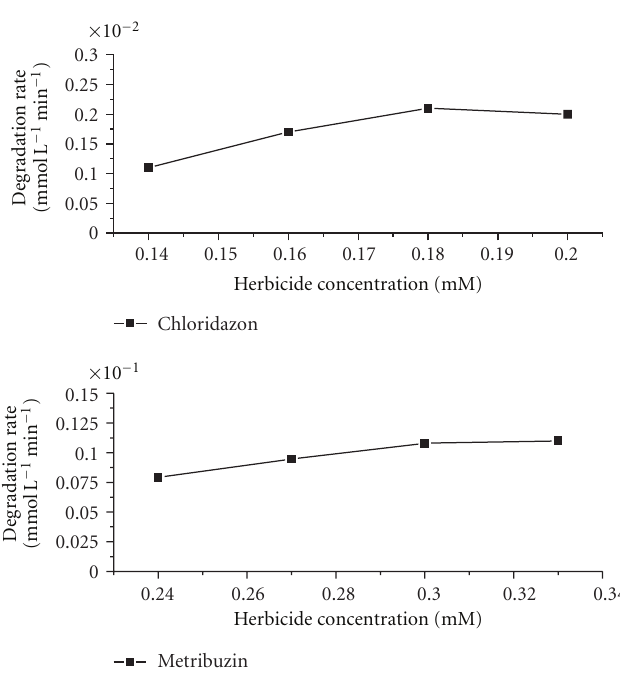
Figure 4: E ff ect of initial herbicide concentration on the degradation rate. Experimental conditions : Herbicide concentration: CHL (0.14, 0.16, 0.18, and 0.20 mM), MET (0.24, 0.27, 0.30, and 0.33 mM), V = 125 mL, photocatalyst: TiO 2 Degussa P25 (1gL − 1 ), irradiation time: 60min (CHL), 28 min (MET).